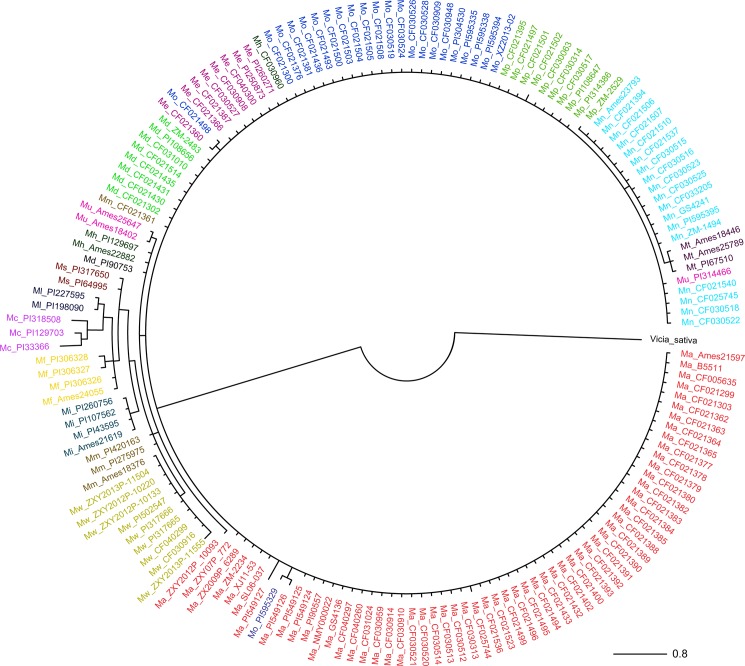
Bayesian tree with branch length, based on psbA-trnH sequences.The abbreviations represent 18 species: Ma—M. albus, Mm—M. altissimus, Md—M. dentatus, Me—M. elegans, Mh—M. hirsutus, Mi—M. indicus, Mf—M. infestus, Mr—M. italicus, Mo—M. officinalis, Mp—M. polonicus, Mg—M. segetalis, Mc—M. siculus, Ms—M. speciosus, Mu—M. spicatus, Mn—M. suaveolens, Ml—M. sulcatus, Mt—M. tauricus, and Mw—M. wolgicus. See S1 Table for the accession numbers.